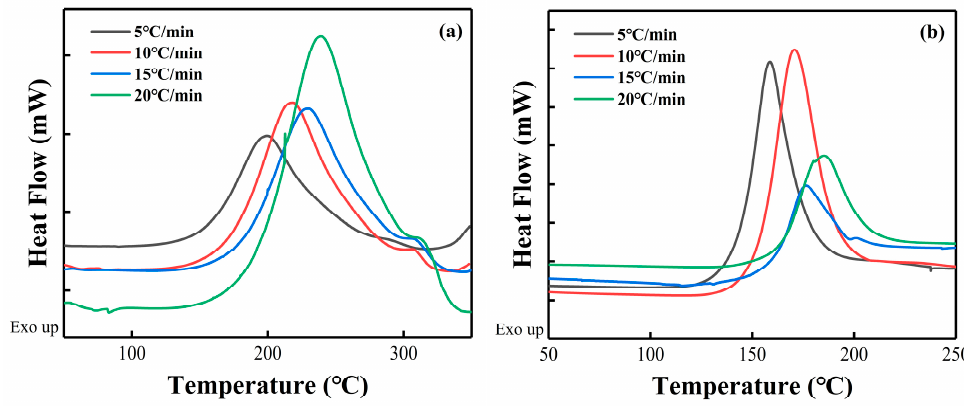
Figure 3. The non-isothermal DSC curves of ( a ) PNE-177/DDS and ( b ) PNE-177/DICY. Table 1. The characteristic temperatures of the pure epoxy/curing agent system.